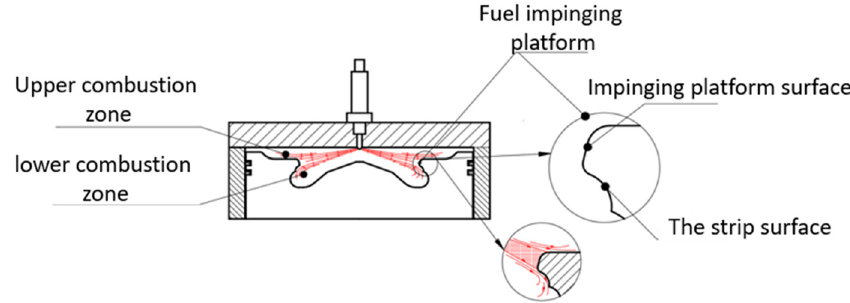
Figure 1: The double - layer split combustion